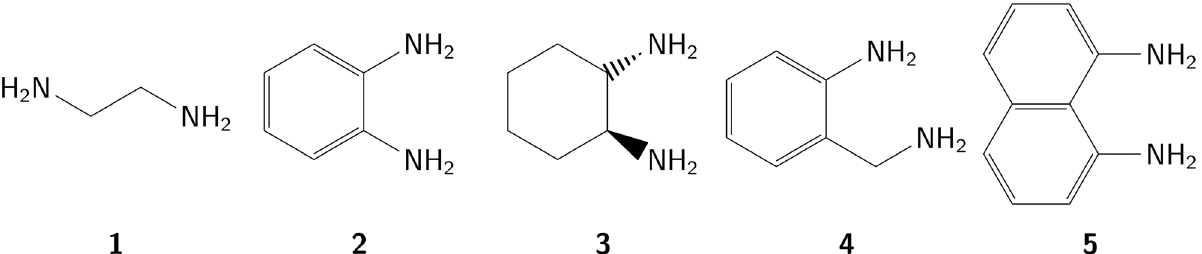
Figure 2: Amines used as starting materials.